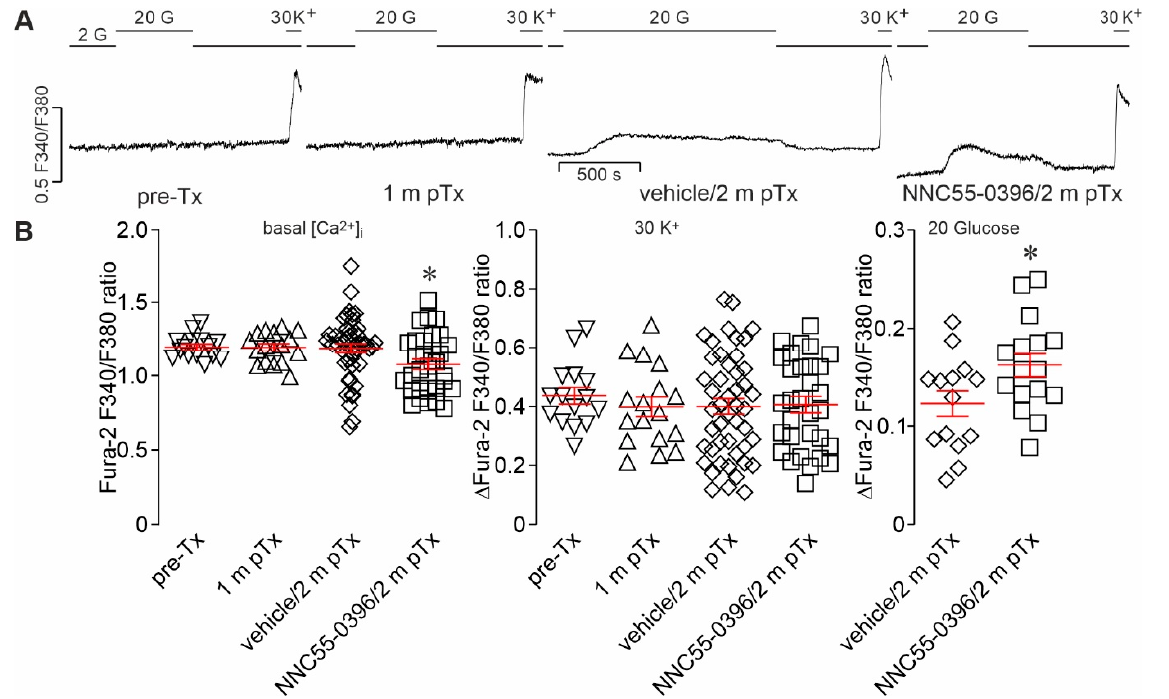
Figure 2. Effects of intravitreal infusion of NNC55-0396 on [Ca 2+ ] i dynamics in intraocular hiPSC- islet grafts retrieved intact. ( A ) Sample traces of fura-2 F340/F380 ratios acquired during sequential perifusion of 2 mM glucose, 20 mM glucose or 30 mM KCl in pre-transplanted hiPSC-islets (pre- Tx); intact, single intraocular hiPSC-islet grafts retrieved l month post-transplantation (1 m pTx) or 2 months post-transplantation following intravitreal infusion of vehicle (vehicle/2 m pTx) or NNC55-0396 (NNC55-0396/2 m pTx). ( B ) Quantification of average fura-2 F340/F380 ratios in pre-Tx, 1 m pTx and 2 m pTx during exposure to 2 mM glucose (n = 15 for pre-Tx group, n = 17 for 1 m pTx, n = 47 for vehicle/2 m pTx group, n = 31 for NNC55-0396/2 m pTx group) ( left ) and stimulation with 30 mM KCl (n = 15 for pre-Tx group, n = 17 for l m pTx group, n = 47 for vehicle/2 m pTx group, n = 31 for NNC55-0396/2 m pTx group) ( middle ) or 20 mM glucose (n = 14 for vehicle/2 m pTx group, n = 16 for NNC55-0396/2 m pTx group) ( right ). * p <